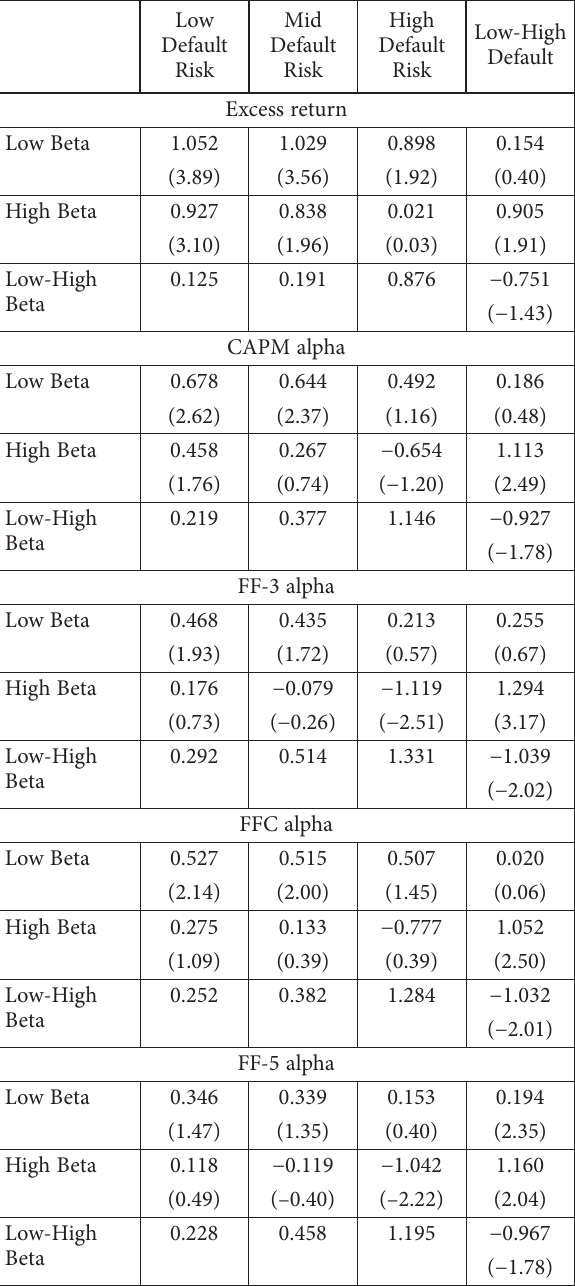
Table 7. Default risk premium and CAPM